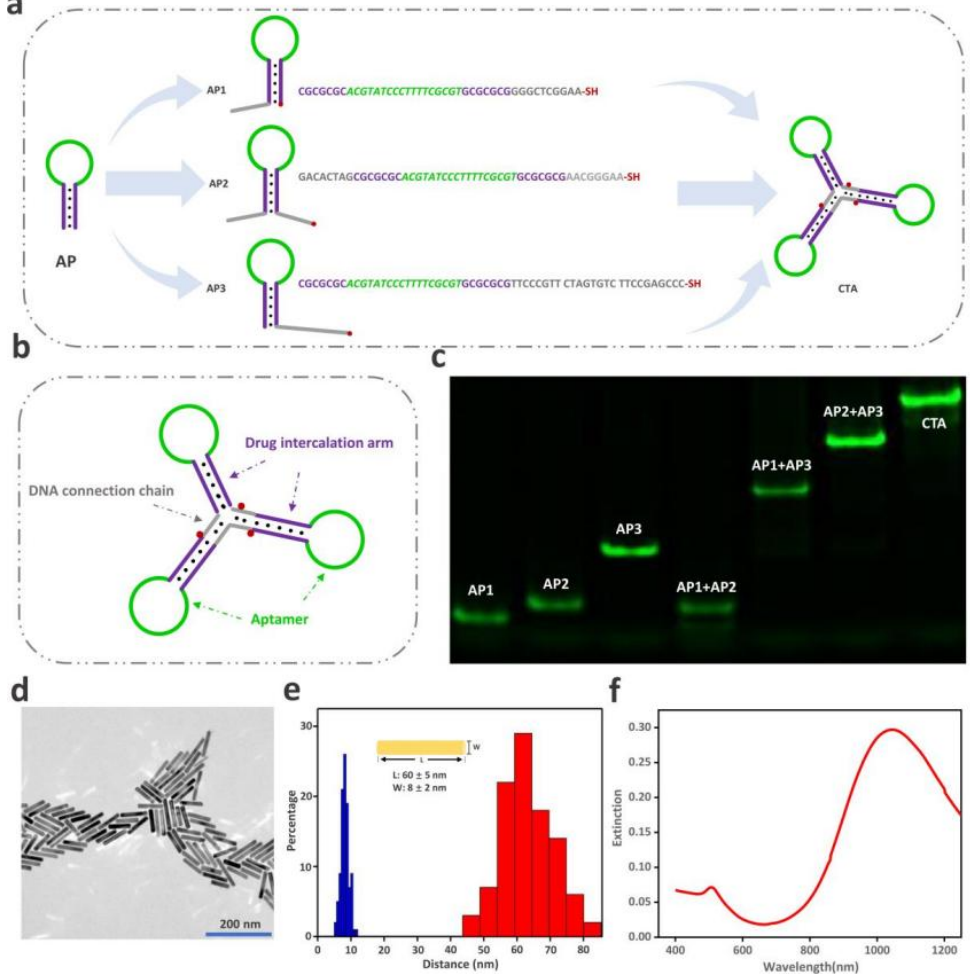
Figure 1. Construction and characterization of GNR@CTA. ( a ) Schematic diagram of CTA, ( b ) Func- tional area division of CTA, ( c ) Gel Electrophoresis Characterization of CTA, ( d ) TEM characterization of GNR, ( e ) Length and width distribution of GNR, and ( f ) UV-visible-NIR spectrum of